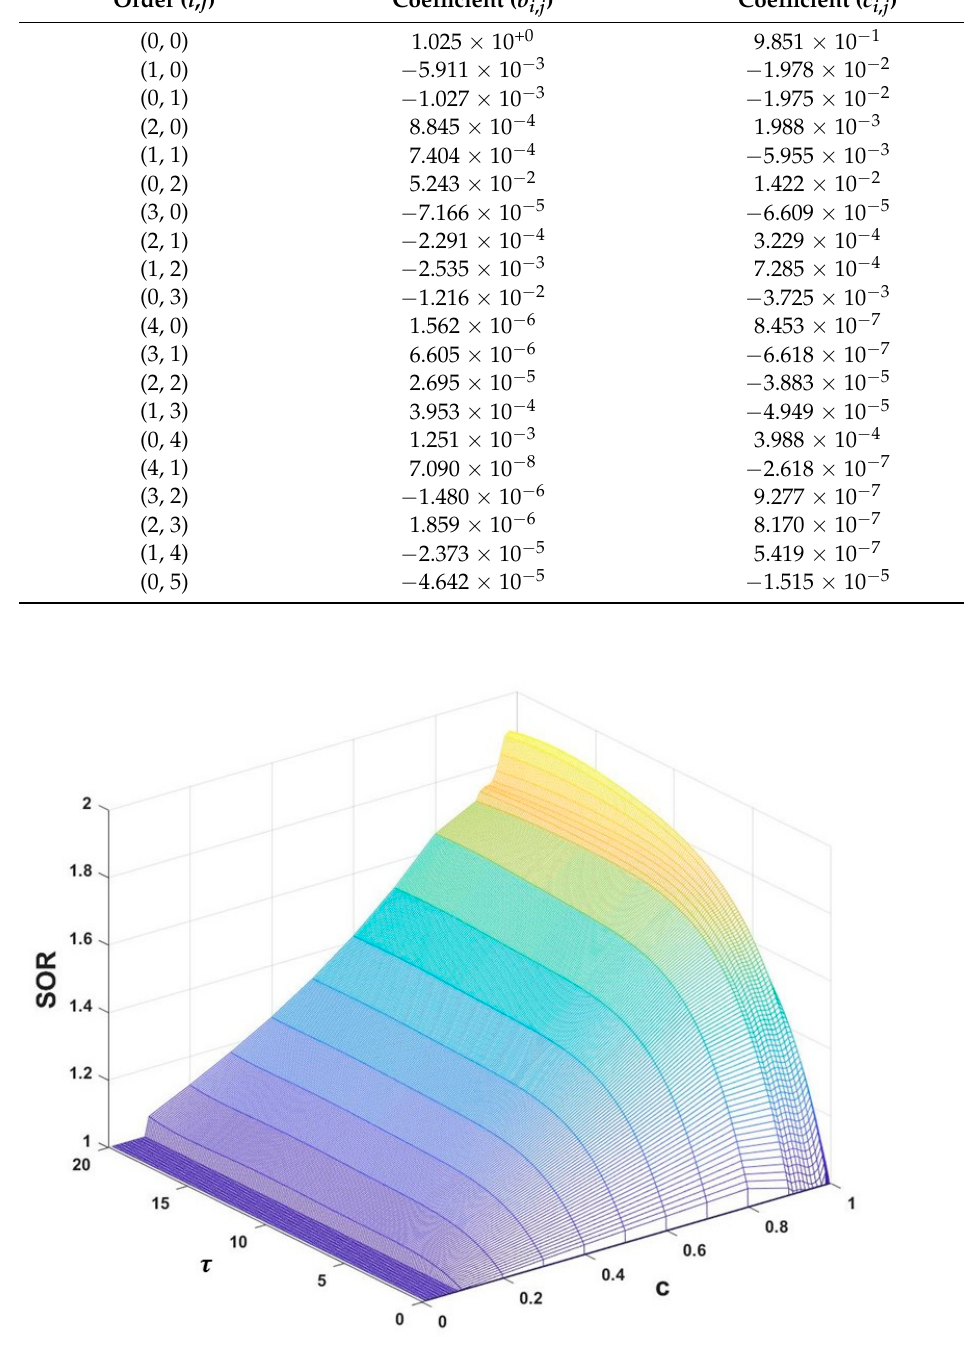
Figure 4. Modified SOR distribution.